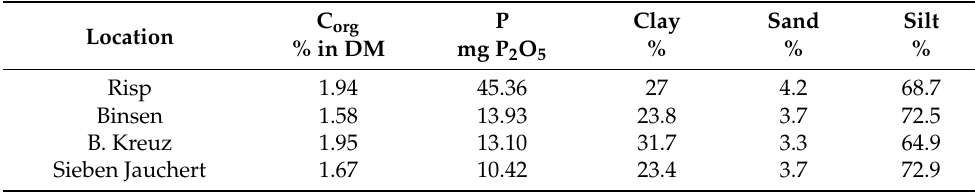
Table 2. Soil properties of the four experimental